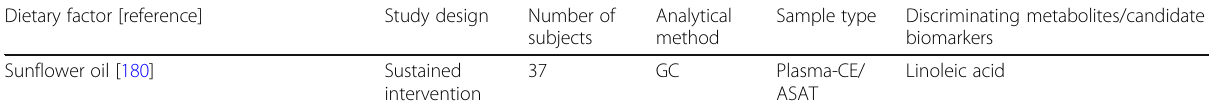
Table 3 Studies reporting associations between consumption and potential candidate food intake biomarkers for vegetable oils (Continued) Dietary factor [reference]